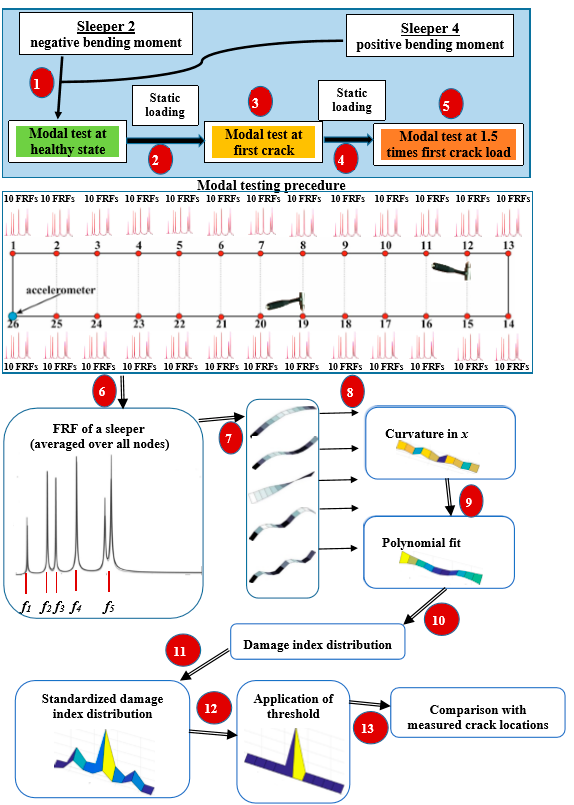
Figure 1. Experimental testing and damage localization